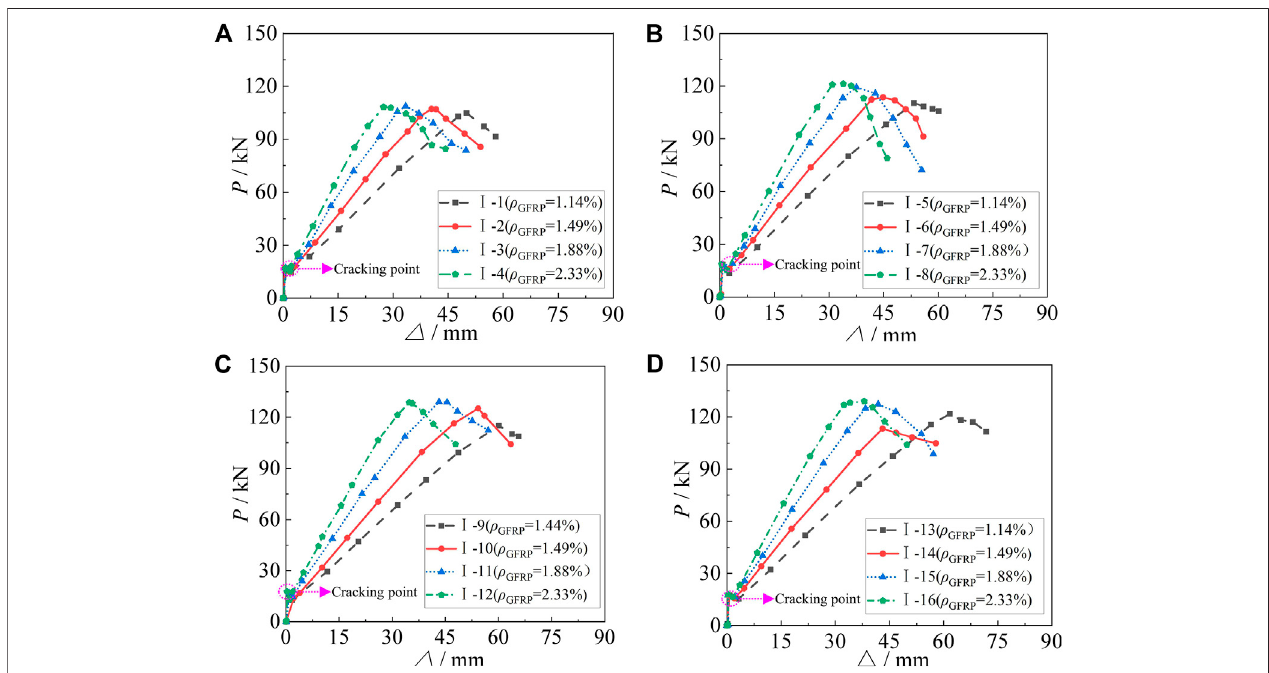
FIGURE 9 | Comparison of load – displacement curves of simply supported beams with different ρ GFRP : (A) h 1 (cid:2) 30 mm; (B) h 2 (cid:2) 60 mm; (C) h 3 (cid:2) 90 mm; (D) h4 (cid:2) 120 mm.